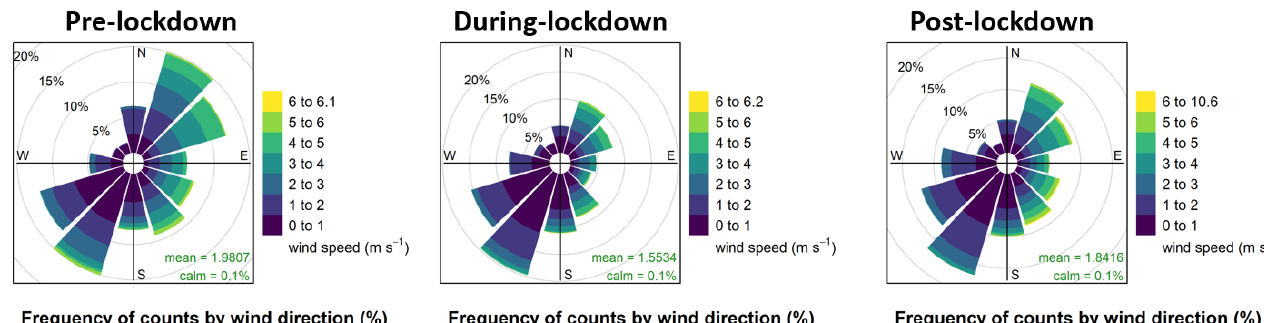
Figure 2. Wind-rose plots for different monitoring periods of the year 2020.